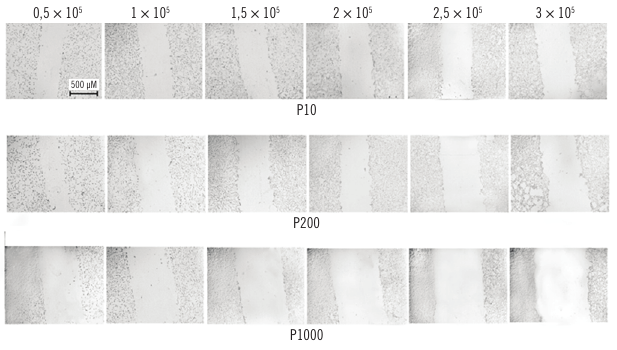
figura 2 – Monocamada celular U87MG e padronização do ensaio de ranhuras in vitro A) As células U87MG foram plaqueadas em diferentes densidades e, após 24 horas de incubação, foram fotografadas para observação da confluência das monocamadas celulares. Em 0,5 e 1 × 10 5 células por poço, a monocamada celular apresentou baixa confluência e, em 2,5 e 3 × 10 5 células por poço, as células começaram a se sobrepor; B) a monocamada foi então arranhada com três tamanhos de pontas de micropipeta. As densidades celulares de 1,5 e 2 × 10 5 /500 µl apresentaram confluência ideal para a realização do